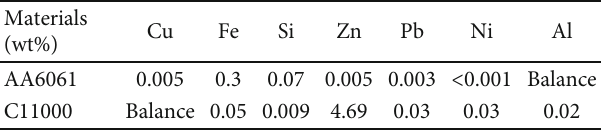
Table 1: Chemical composition of AA6061 and C11000 wires.